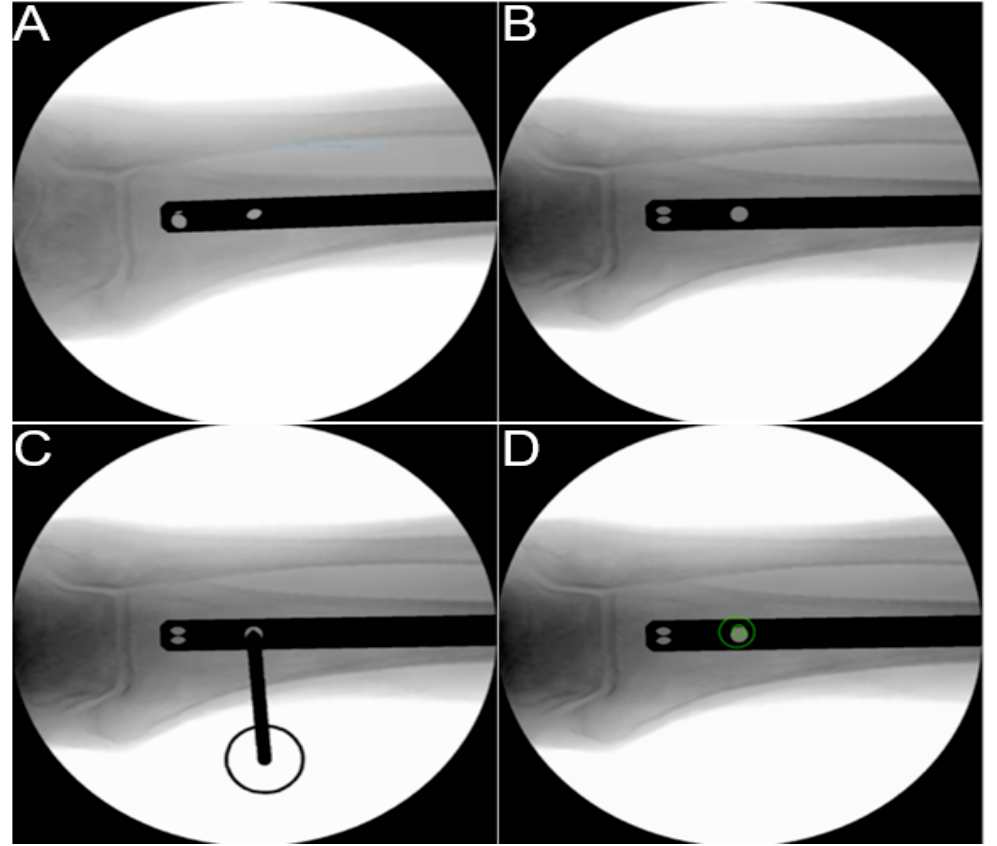
Figure 2. Sequence of simulated X-ray images of distal nail interlocking. ( A ) Arbitrary starting position; ( B ) “Perfect circle” hole projection after aligning the C-arm; ( C ) Drill tip positioned in the center of the hole; ( D ) Drilling of the hole after aligning the drill tip with the X-ray beam for a “bullseye shot” and resulting drilling trajectory indicated by green circles.